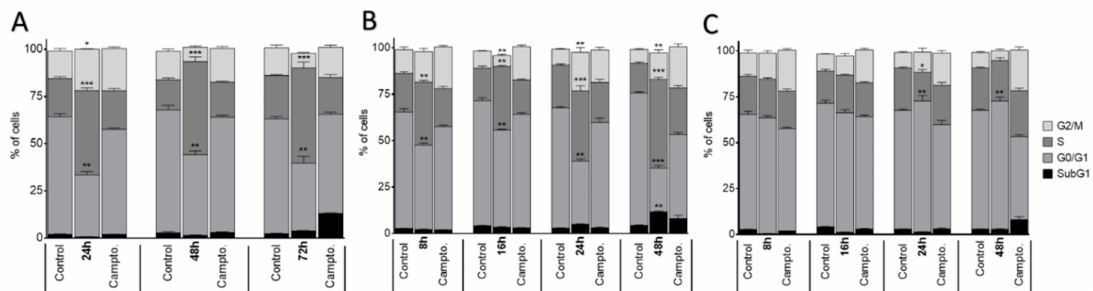
Figure 7. Cell cycle phase distribution of MCF-7 cell cultures treated for different time periods with I.1f (80 µ M) ( A ), I.2f (30 µ M) ( B ) and II.2d (5 µ M) ( C ). * Statistical significance with values of p < 0.05; ** statistical significance with values of p < 0.01; *** statistical significance with values of p < 0.001.